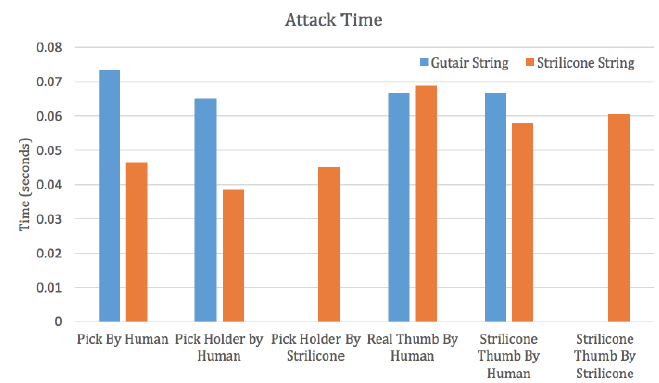
Fig. 21. Group I illustrating the attack time on both a standard guitar string and their chordo- phone string using a regular pick, a pick in the holder, real thumb and silicone thumb.